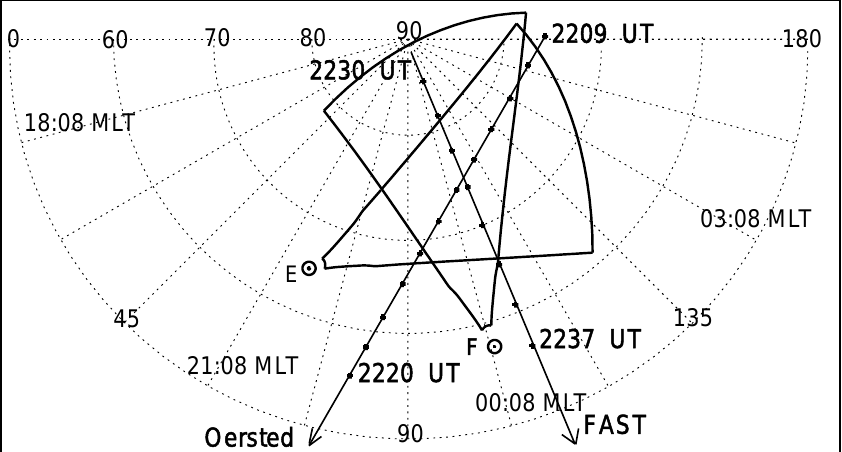
Fig. 1. Common field-of-view in mag- netic coordinates of the CUTLASS Hankasalmi (F) and Pikkvibær (E) radars at 22:20 UT, with the FAST and Ørsted trajectories